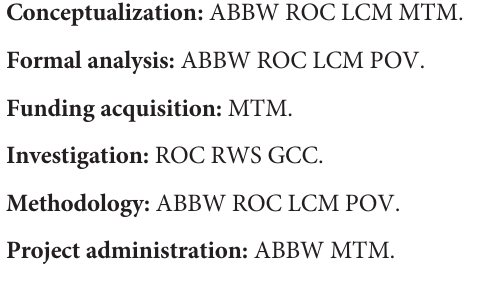
S1 Table. Comparisons of the three genera ( Aedes , Anopheles and Culex ) using the pairwise cross-validated reclassification test and five, seven and nine